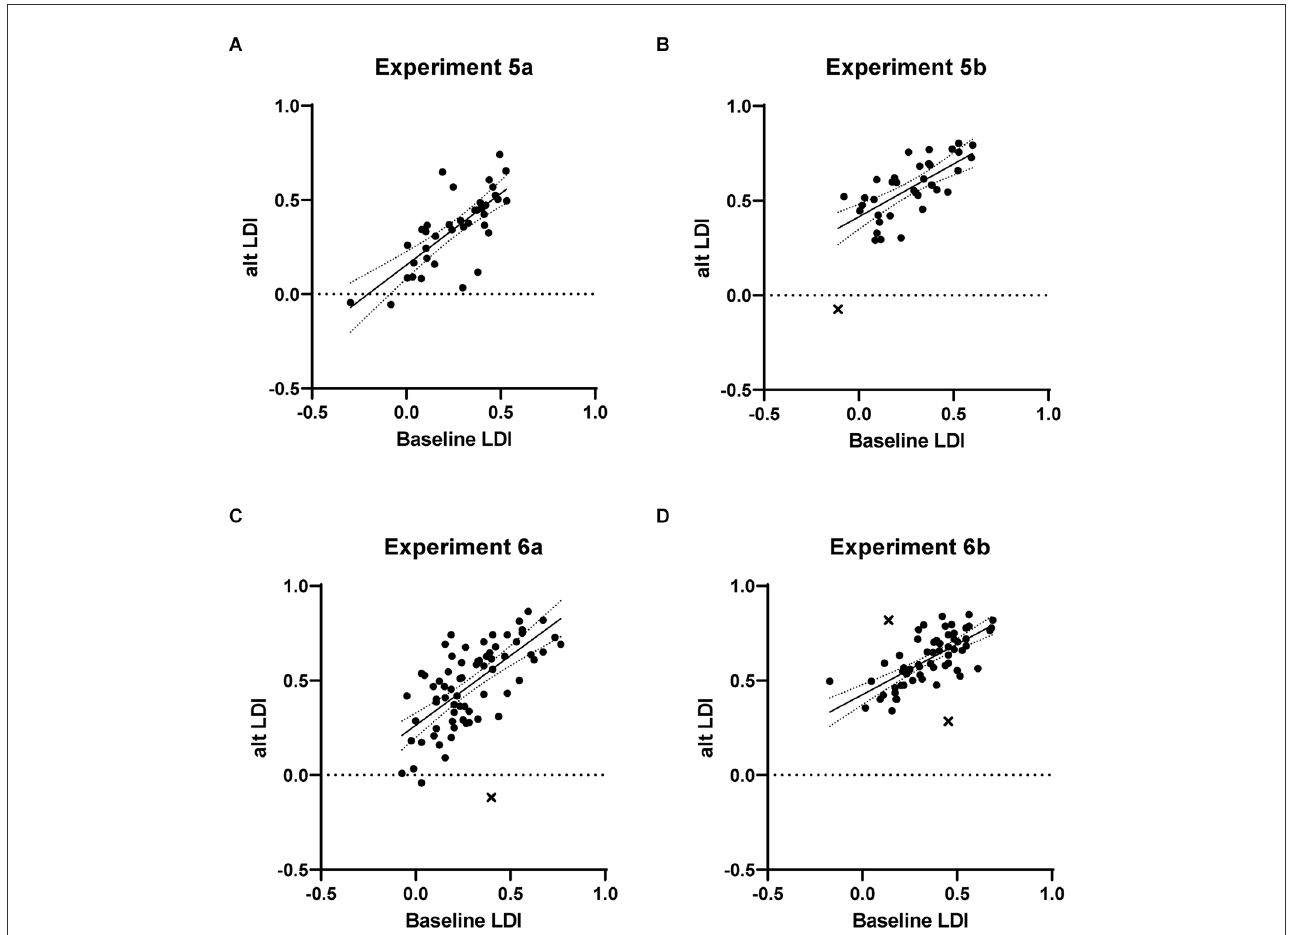
FIGURE3 Results from Experiments 5 and 6 testing the effect of strategic reductions in the number of stimuli (Experiment 5) and the use of a practice task (Experiment 6). In both the study-test (panels A and C ) and continuous (panels B and D ) versions, strong correlations with the baseline MST were observed. Points identified as outliers are indicated with